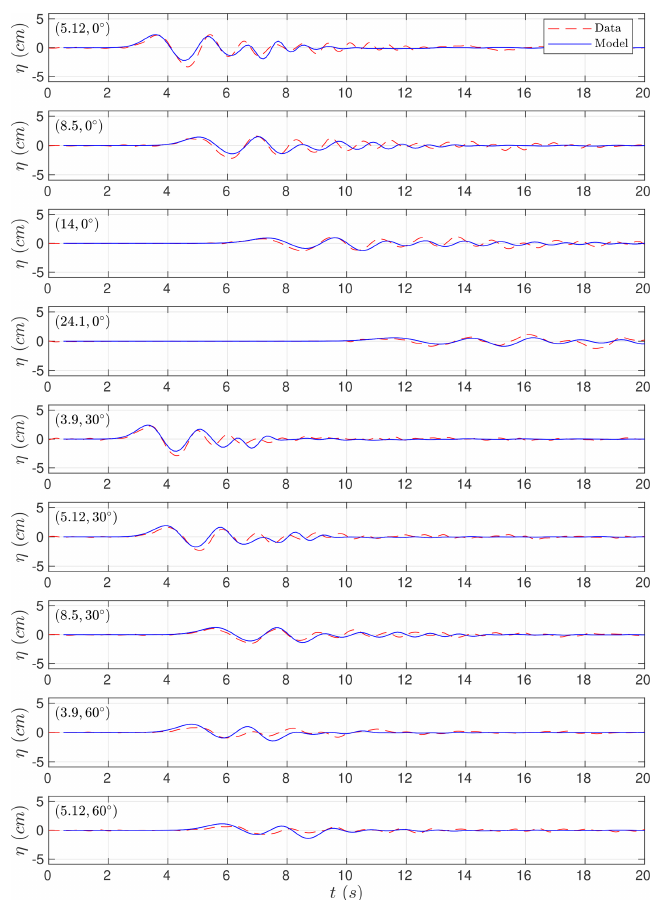
Figure 11. Simulated (solid blue lines) time series compared with measured (dashed red lines) free-surface waves for the nine wave gauges considered at ( R , θ ◦ )